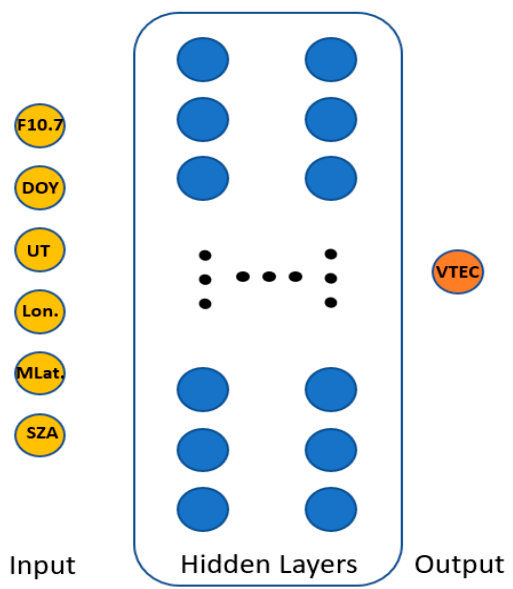
Figure 3. General architecture of the fully connected neural network (NN). The model training was optimized using an optimization method called Adam [31], which considers a learning rate of 0.0001 and the Mean Squared Error (MSE) as the loss function. The Adam optimizer minimizes the MSE and is a computationally effective algorithm with little memory requirements [31]. The loss function is defined as the MSE between model prediction and VTEC from the GIMs, also known as label. The training process took several hours, which can be considered as short since no special hardware was used other than a personal computer with an Intel Core i7-8665U CPU and 16 GB RAM. The number of epochs used for the model’s training was 150, which stands for how many times the complete training dataset is passed through the network. The model was fitted using a batch size of 128. The batch size is the number of samples that are being fed to the